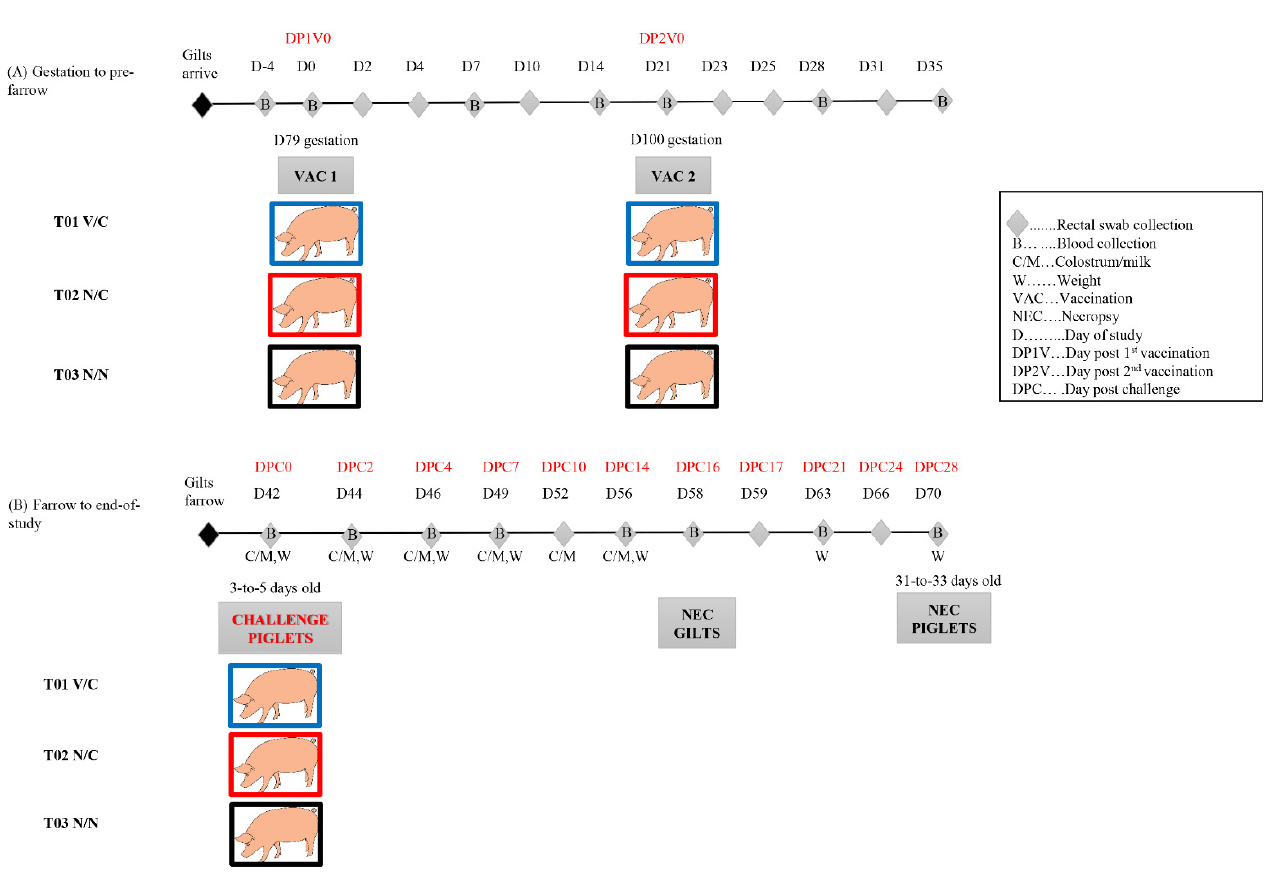
4 of 18 Table 1. Experimental design of vaccination and challenge schedules. Group Number of Gilts/Litters 1st Vaccination (79 Days of Gestation) 2nd Vaccination (100 Days of Gestation) Piglet Challenge Wean Piglets